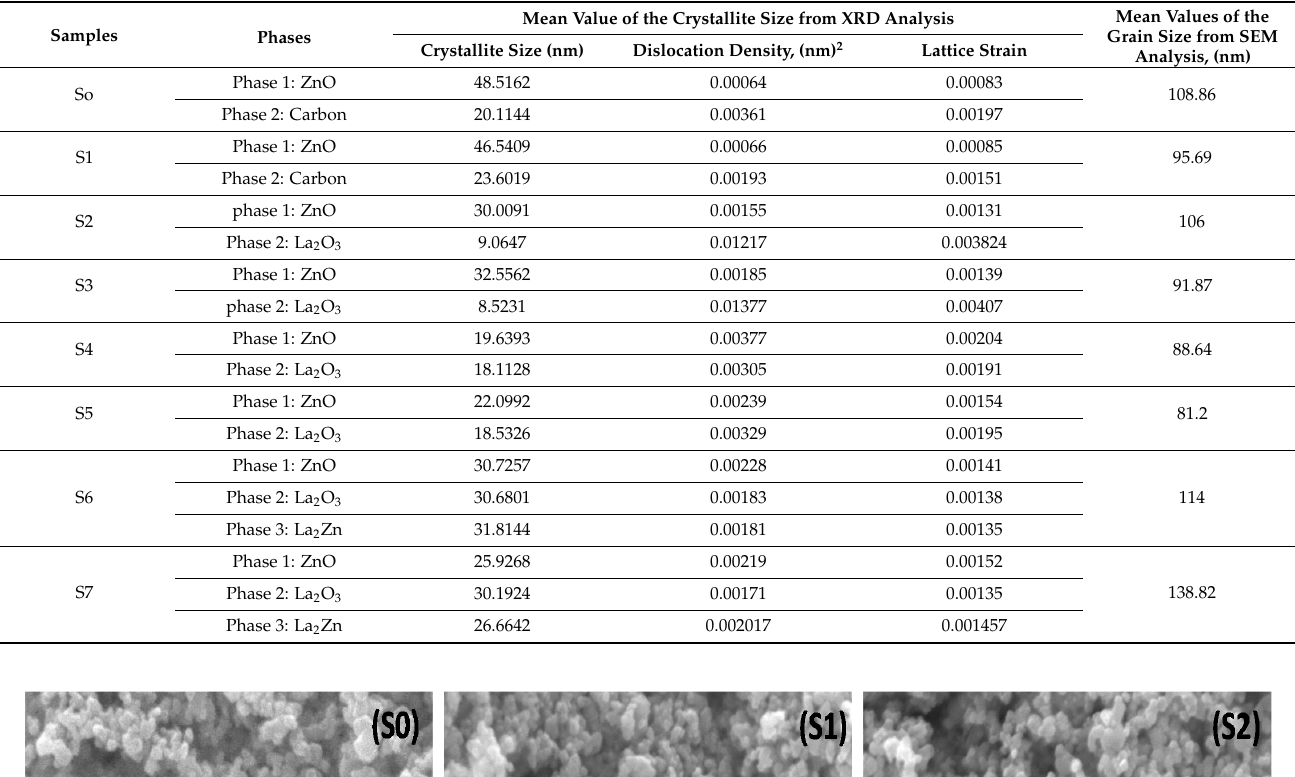
Grain Size from SEM Analysis, (nm)Crystallite Size (nm)